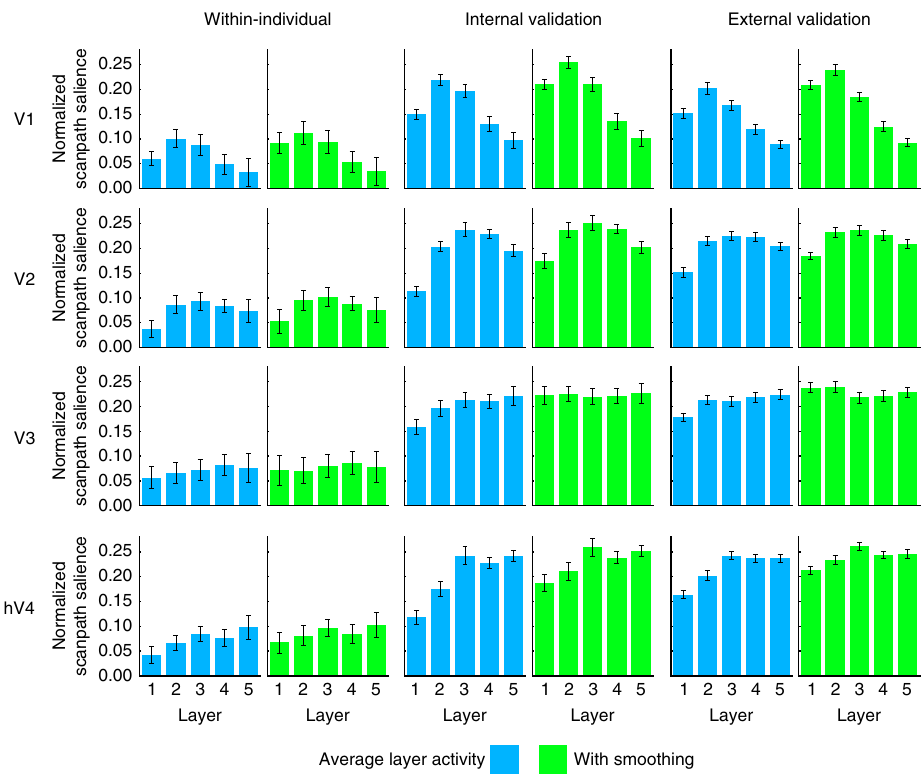
With smoothing Fig. 6 Layer-speci fi c reconstructions predict eye movement patterns. We see a correspondence between the layer hierarchy in the CNN and the visual hierarchy in the brain, such that reconstructions of early/late layers from early/late visual regions, respectively, best predict eye movement patterns. Spatial reconstructions for each layer were calculated by averaging across the feature-based channel dimension in CNN-aligned fMRI activity. Results are shown for unsmoothed and smoothed reconstructions. All layers for all shown ROIs are signi fi cant at P < 1 × 10 – 3 (determined using permutation testing). Error bars represent standard error of the mean within the current data set ( n = 11, Within-individual and Internal validation) or within the external validation data set ( n = 22, External